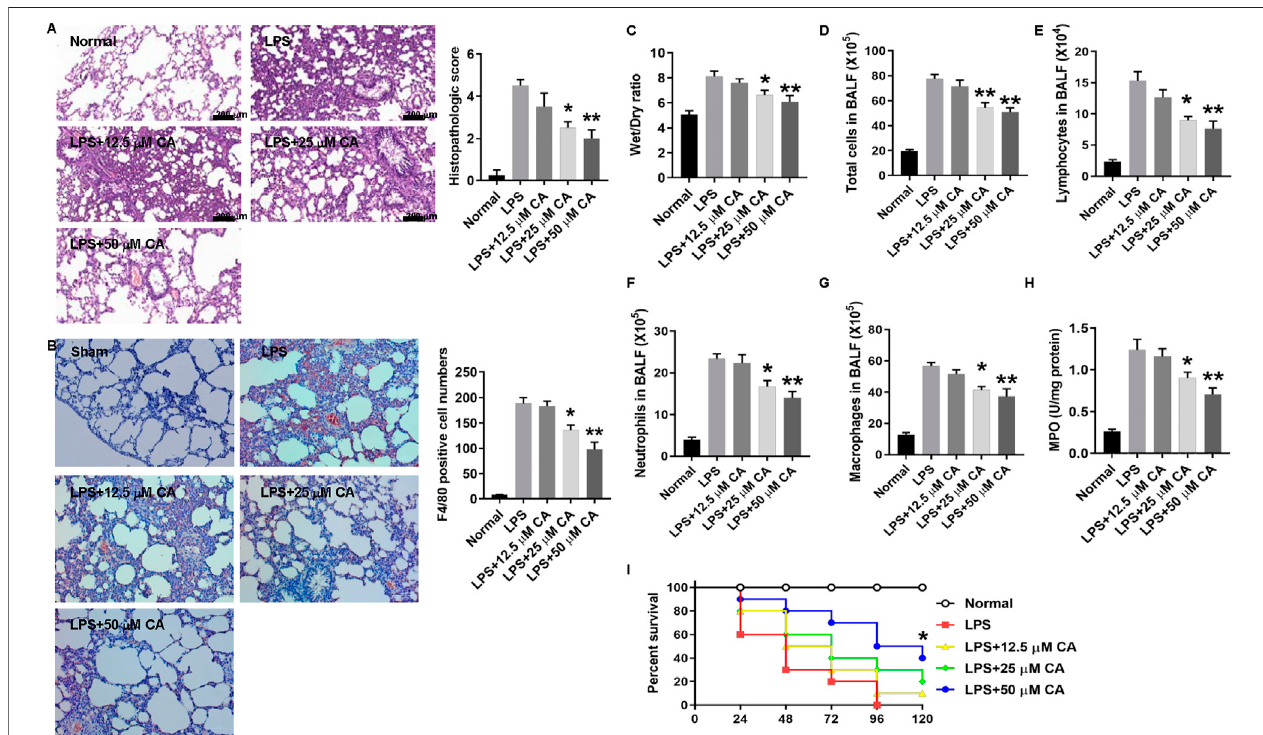
FIGURE 2 | Calycosin protects against lipopolysaccharide (LPS)-induced septic acute lung injury. Mice were injected intraperitoneally (i.p.) with 10 mg kg − 1 LPS and 30 min later intravenously (i.v.) with 2.6 μ Lg − 1 oleic acid (OA). Mice were treated with calycosin by gavage at 0 and 6 h after LPS injection. After LPS injection for 12 h, mice wereanesthetizedandsacri fi ced. (A) Lungtissueswerestainedwithhematoxylinandeosin.Histopathologicscoreswerecalculatedaccordingtotheseverityoflungdamage. (B) LungtissueslideswerestainedbyF4/80immunohistochemistry.Thenumbersofpositivecellswerecountedandstatisticallyanalyzed. (C) Thelowerpartoftheright lungwasexcisedandweighedtoobtainthewetweight.Then,thewetlungwasdriedinanovenat72 ° Cfor48 htoobtainthedryweight.Theratioofwettodry(W/D)weight wascalculatedtoassessthelungedema. (D) ThetotalcellnumberintheBALFwasdetermined. (E – G) ThecellnumbersintheBALF,includingmacrophages,lymphocytes, andneutrophils,weredeterminedbytheWright – Giemsastaining. (H) MPOactivitywasdetermined.Allthequantitativedata (A – G) arepresentedasmeans ± SEM.* p < 0.05; ** p < 0.01vs.theLPSgroup. (I) MiceweretreatedwithdifferentdosesofcalycosinbygavageonceperdayafterLPSinjection.Themortalityofmicewasmonitoredevery24 h for 5 days after LPS injection (10 mice per group). The Kaplan – Meier method was used to compare the differences among groups. * p < 0.05 vs. the LPS group.